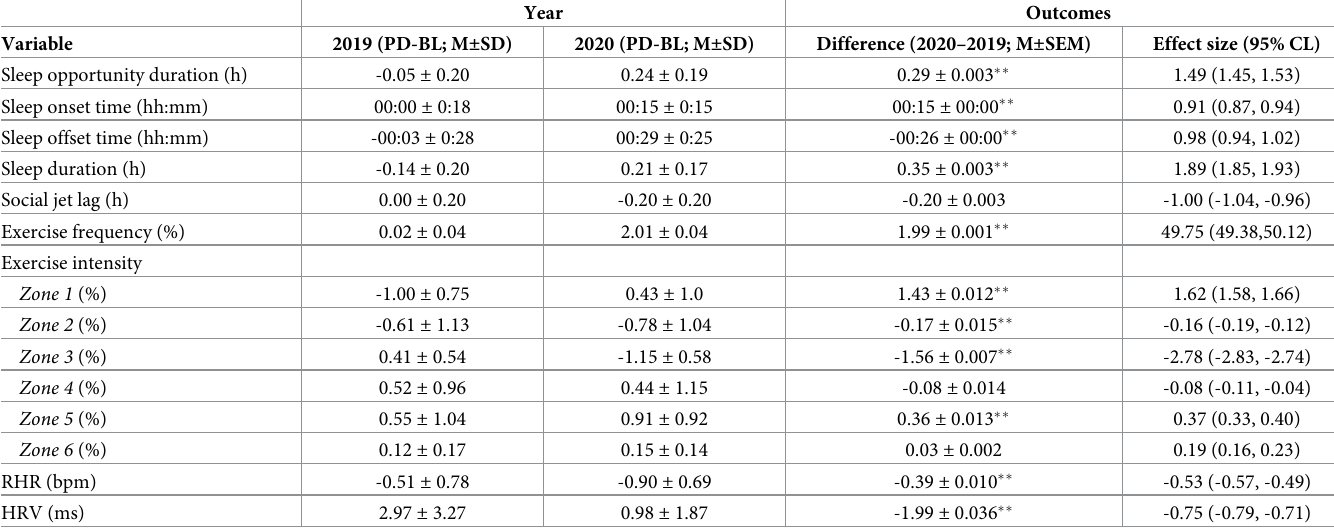
Table 6. Differences in sleep and exercise related variables as a function of